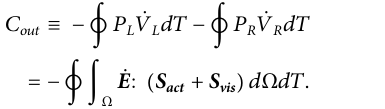
7A,B, where the two cases of the myosin rod stiffness with k xb = 2.8 pN/nm (black lines) and k xb = 1.4 pN/nm (red lines) are compared. The solid lines and broken lines represent, respectively, the blood dynamics and the muscle dynamics.